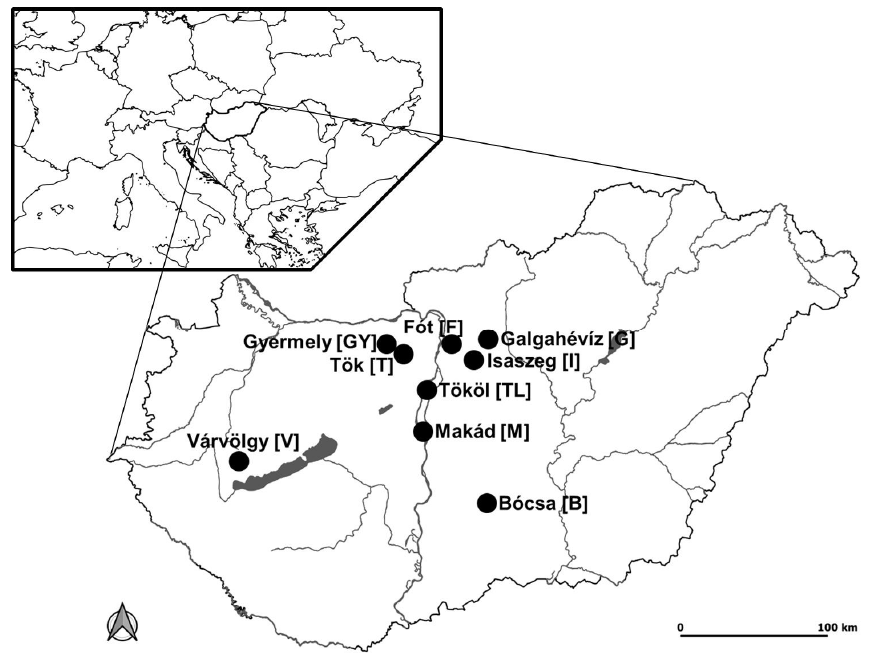
Figure 1. Location of the study sites. Table 1. Basic data of the study sites (sources [25–27]).